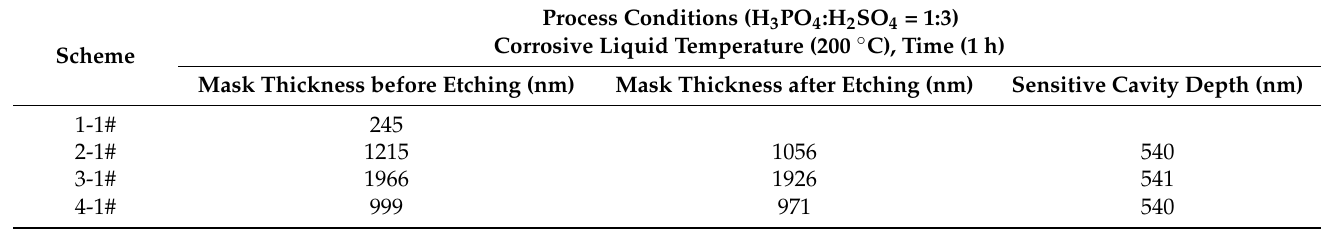
Table 2. Process results at 200 ◦ C.